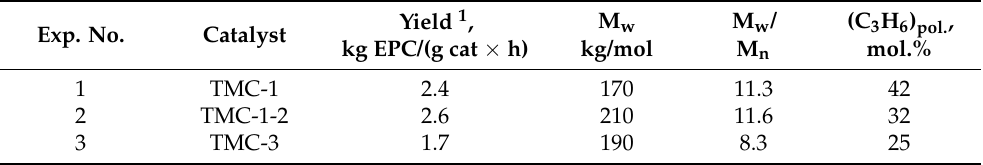
TMC-1-2 catalyst at a molar ratio С 6 / С 2 = 2.3 (exp. 6 in Table 2). 3 Obtained on the TMC-2 catalyst at a molar ratio С 6 / С 2 = 4.5 (exp. 10 in Table 2). 4 Obtained on the TMC-3 catalyst at a molar ratio С 6 / С 2